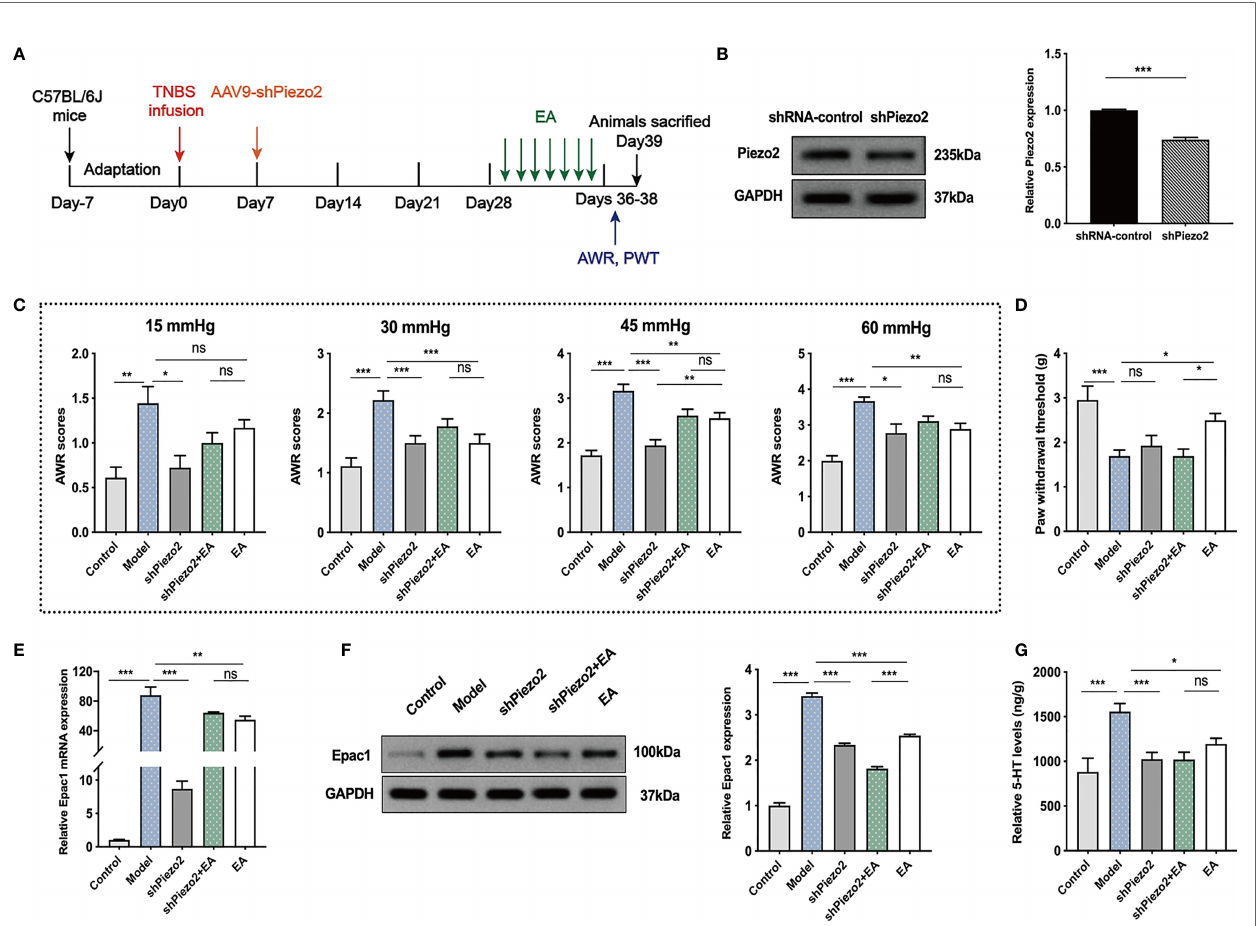
FIGURE 6 | Knockdown of Piezo2 eliminated the effect of EA on somatic hypersensitivity. (A) Schedule of the experimental procedures. (B) Representative Western blot analyses of Piezo2 staining and relative protein levels between the shRNA-control and shPiezo2 groups (n=3 per group). (C, D) Abdominal withdrawal re fl ex scores and hind paw withdrawal threshold evaluated in each group (n=6 per group). (E) Relative colonic Epac1 mRNA expression (n=3 per group). (F) Representative Western blot analyses of Epac1 staining and relative protein levels in the colonic tissues (n=3 per group). (G) ELISA analysis of 5-HT in colonic tissues (n=6 per group). Data are presented as mean ± SEM; (B) two-tailed t test; (C-G) One-way ANOVA with LSD multiple comparisons test; * P < 0.05, ** P < 0.01, *** P < 0.001, ns P